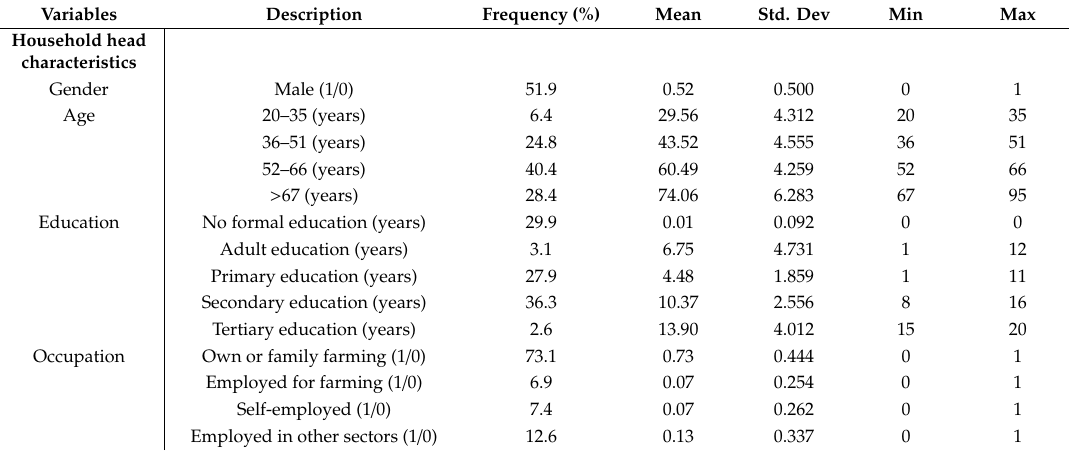
Table 2. Demographic and socio-economic characteristics of smallholder farmers ( n =